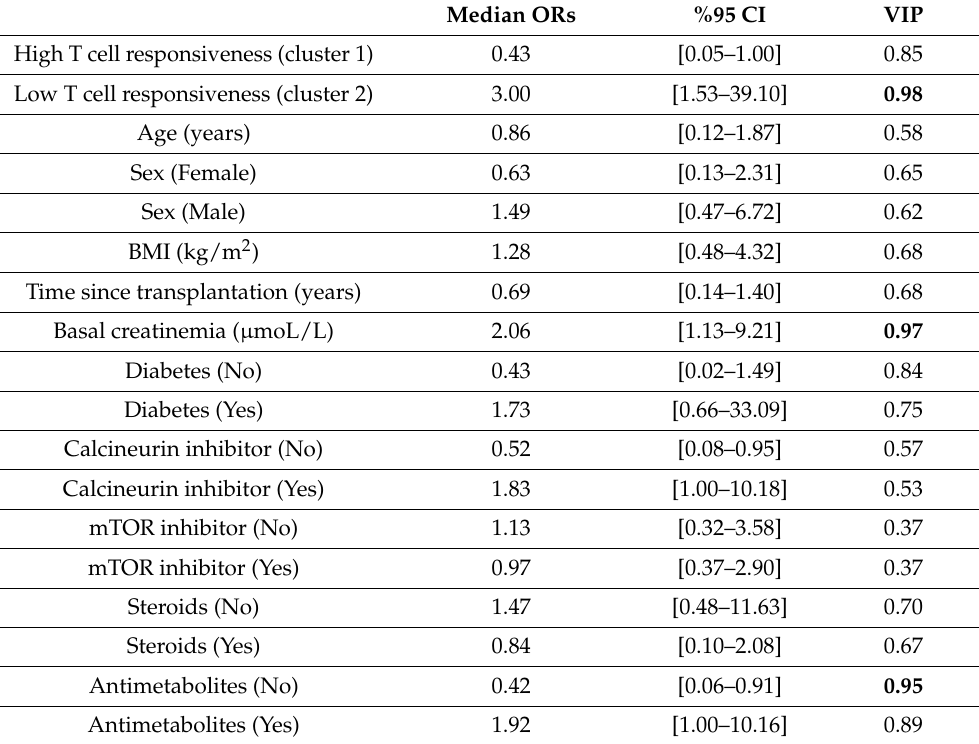
Table 3. Association between clinical outcome and patient T cell